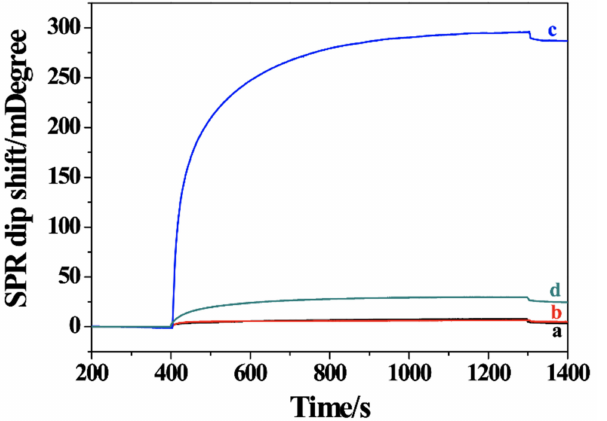
Figure 3. SPR sensorgrams for injection of Ab 1 -MNPs (curve a), A β 40 /Ab 1 -MNPs (curve b), bio- Ab 2 /A β 40 /Ab 1 -MNPs (curve c) and bio-Ab 2 /A β 40 /Ab 1 (curve d) into the NA/BSA/GSH-modified chip. The concentration of A β 40 was 2.5